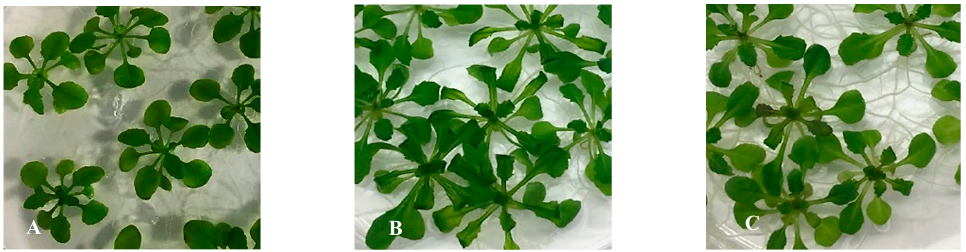
Figure 2. Phenotypic appearance of Arabidopsis thaliana Col-0 on p -coumaric acid at 14 days of culture. ( A ) Seedlings cultured on 0.7% ( w/v ) Micro-agar (control), ( B ) Seedlings cultured on 0.4% ( w/v ) gelrite and ( C ) Seedlings cultured on 0.4% ( w/v ) gelrite + 100 uM p -coumaric acid. Bar = 5 mm.